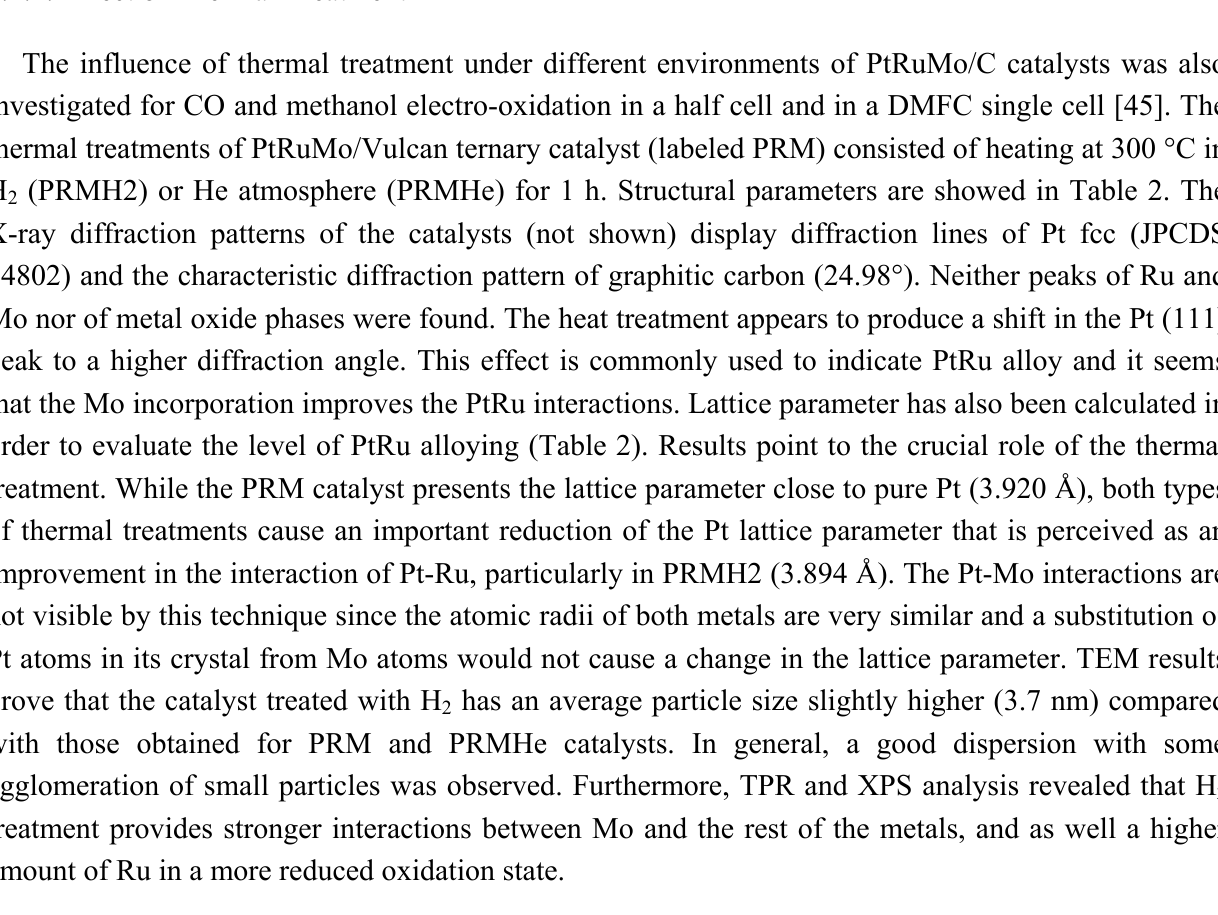
Table 2. Effect of thermal treatment. Structural parameters of the